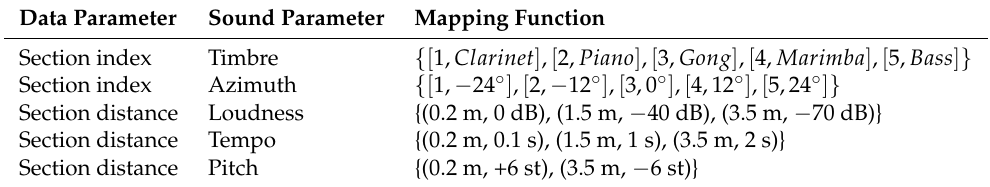
Table 2. Parameter mapping rules of obstacle sonification. Sections in the polar coordinate system is mapped to the parameters of